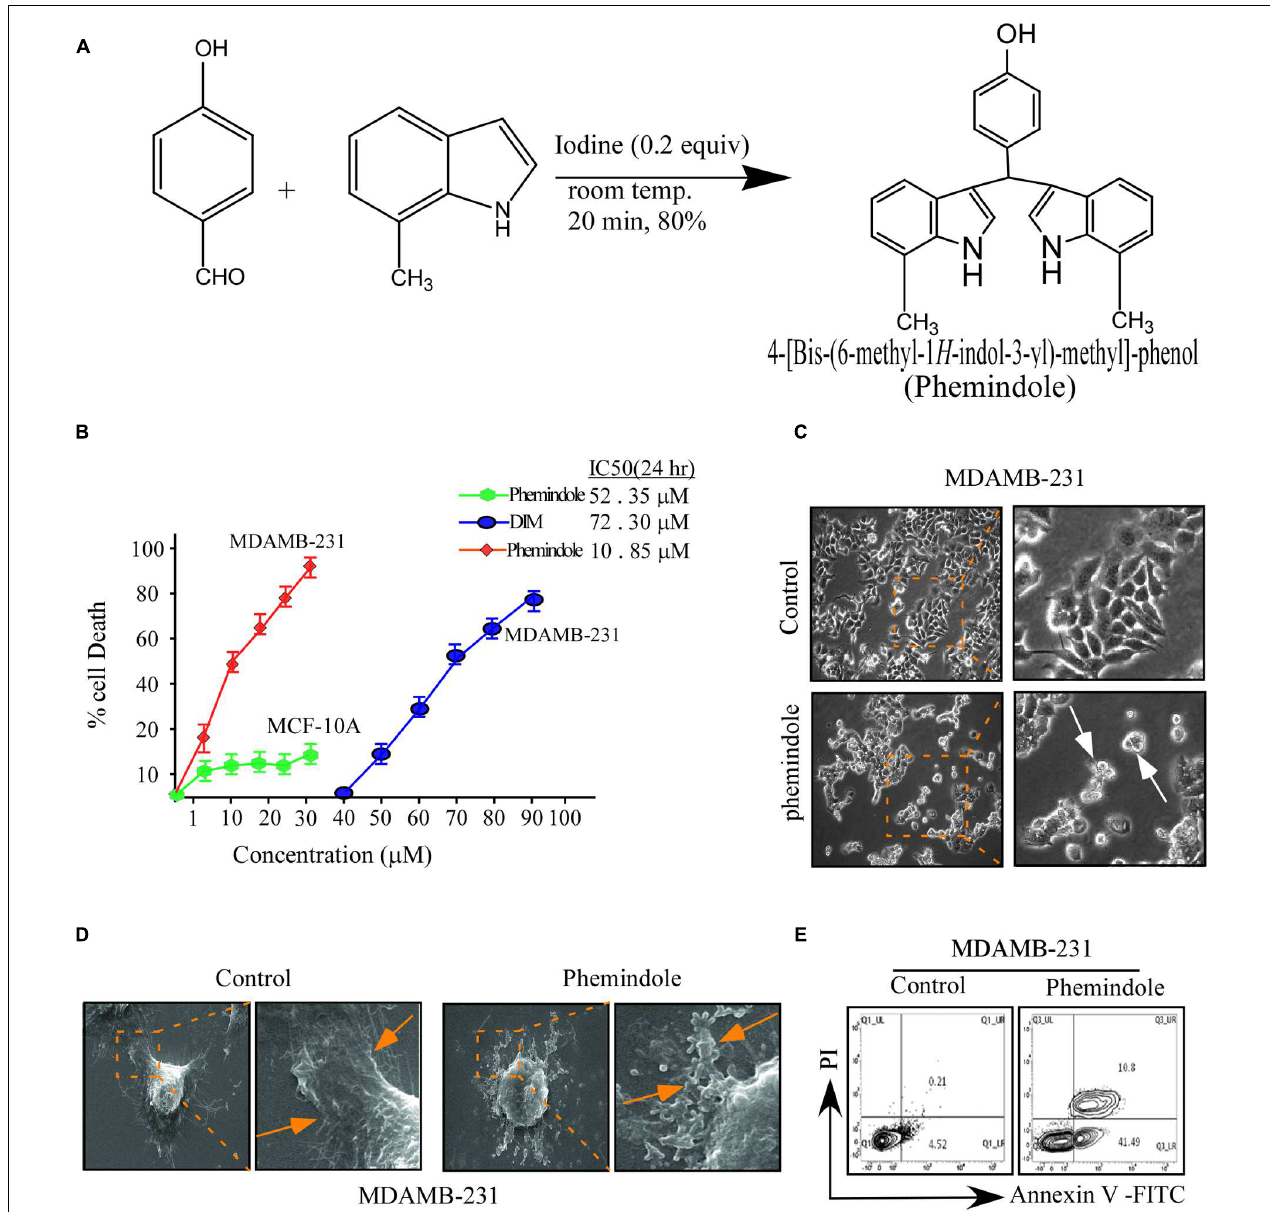
FIGURE 1 | Effects of di-indolyl methane analog, Phemindole on cell viability and apoptosis in human triple negative breast cancer cells. (A) The chemical structure of di-indolyl methane and its analog, Phemindole. (B) The effect of Phemindole on cell viability in human breast cancer cells, MDAMB-231 and normal breast epithelia, MCF-10A. Cells were treated with Phemindole and DIM at different concentrations for 24 h as indicated cell viability was determined by MTT assay, IC50 values were indicated for each treatment. (C) Phase contrast images showing the effect of Phemindole (10 µ M) on MDAMB-231 cells. Arrows in the treated sets are indicating apoptotic cells. (D) SEM micrographs of MDAMB-231 cells showing cellular membrane blabbing due to apoptosis in Phemindole treated set (indicated by arrows) (right). Untreated control cell showed normal morphology (left) (E) Representative images for cell apoptosis stained with Annexin V-FITC/PI. Cells were treated with Phemindole at 10 µ M concentration for 24 h, followed by staining with Annexin V-FITC/PI and analyzed by flow cytometry as described in methods. Values are mean ± SE from three independent experiments. * p < 0.05, ** p < 0.01; all versus control